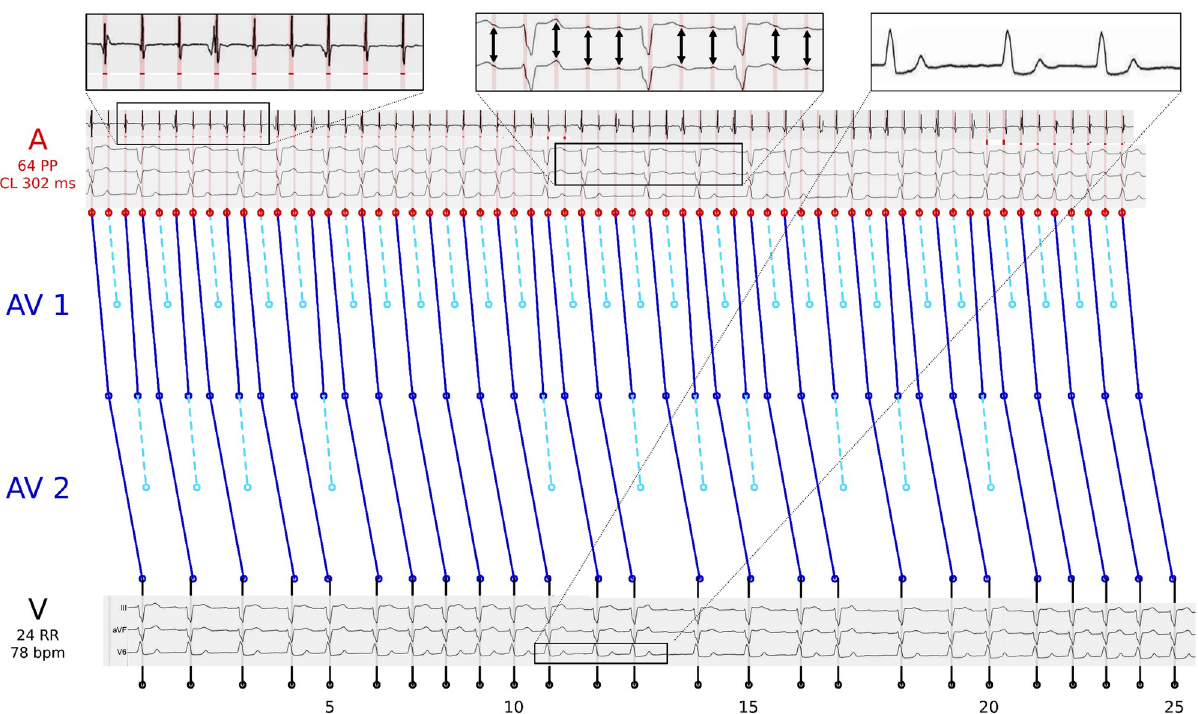
Fig 4. Exemplary illustration of how the feature atrial cycle length derived from a HEAT solution can be a posteriori pathophysiologically interpreted and used.